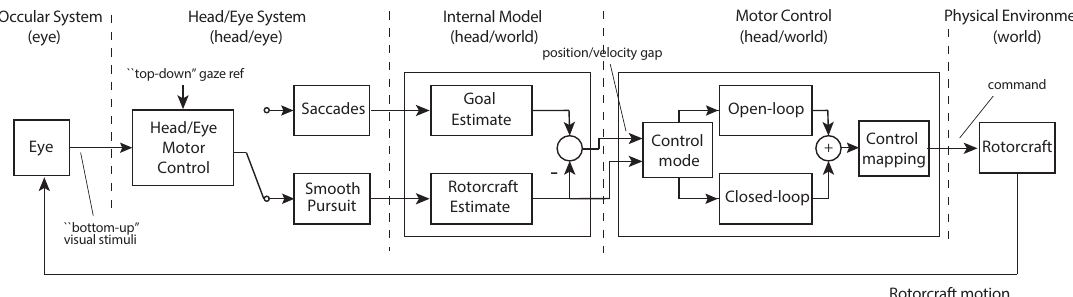
Figure 18. Block diagram of a notional model of the gaze control and helicopter control integration.